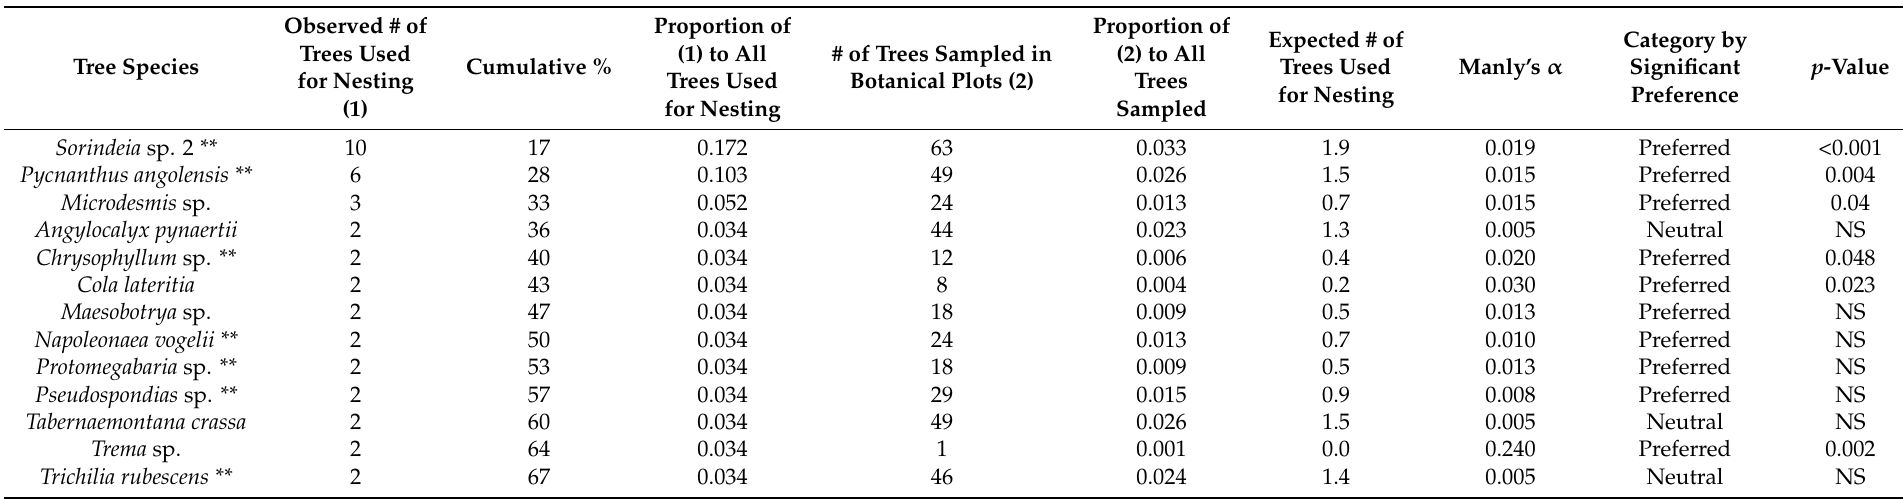
Pseudospondias sp. ** Tabernaemontana crassa Trema